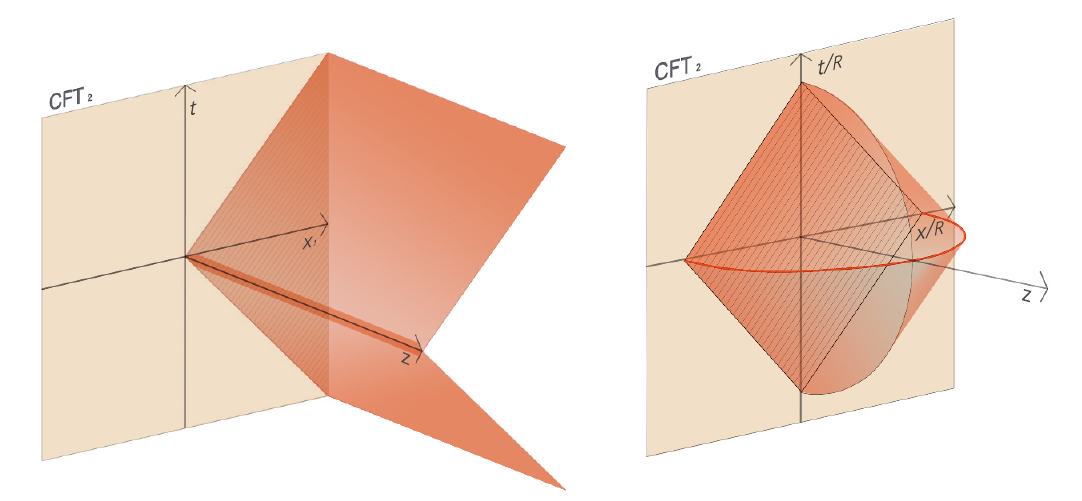
Figure 4 . Diagram of the horizon of the massless hyperbolic black hole in the Poincare AdS section given in eqs. (4.6) and (4.8), after the change of coordinates in eq. (4.4) (left diagram) and eq. (4.7) (right diagram). Notice that for z = 0 it intersects with the boundary of D HS and D B respectively. In both diagrams the bulk horizon at (cid:12)xed time t = 0 has been highlighted in